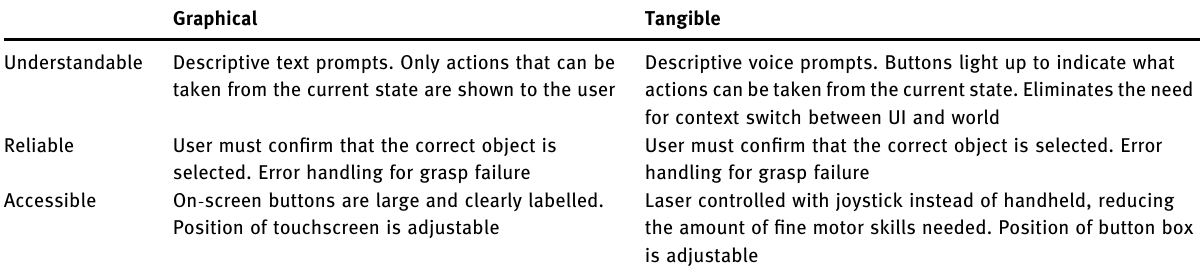
Table 1: Description of how both UIs comply with our design principles Graphical Tangible